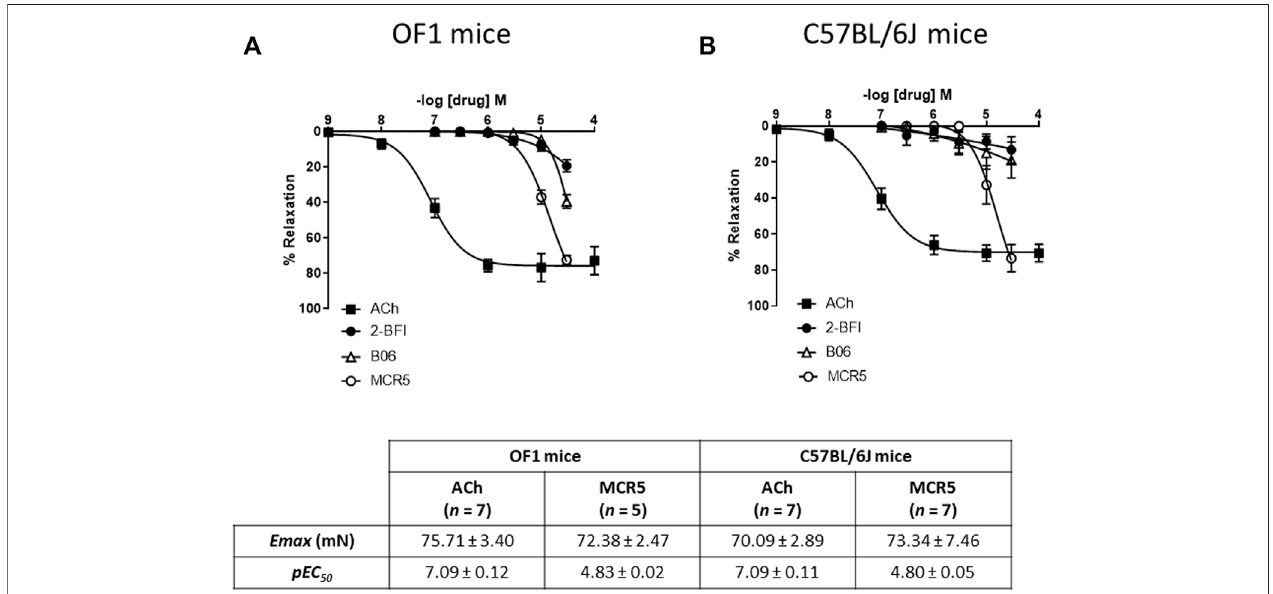
FIGURE 1 | Comparison of I 2 R ligands relaxations. Concentration-response curves to acetylcholine (ACh) and I 2 R ligands in U46619-pre-contracted aortic rings fromyoungOF1 (A) andC57BL/6J (B) mice.Maximumresponse( E max )andpotency( pEC 50 )ofAChandMCR5relaxationsareshownatthebottom.Resultsaremean± SEM from n = 7 (ACh), 5-7 (2-BFI), 6 (B06), 5-7 (MCR5) mice.